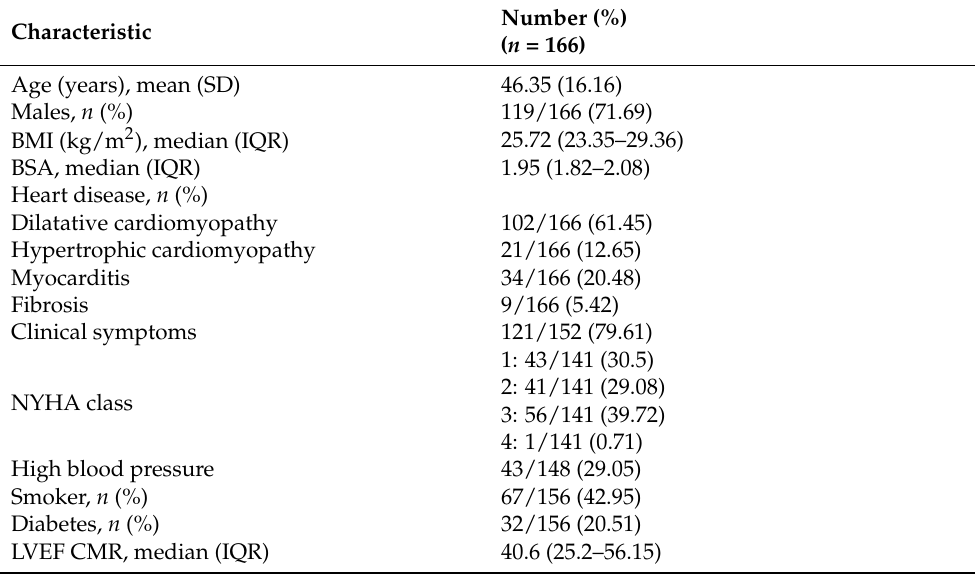
Table 1. Patients’ characteristics, along with cardiac assessment using 2D echography and cardiovas- cular magnetic